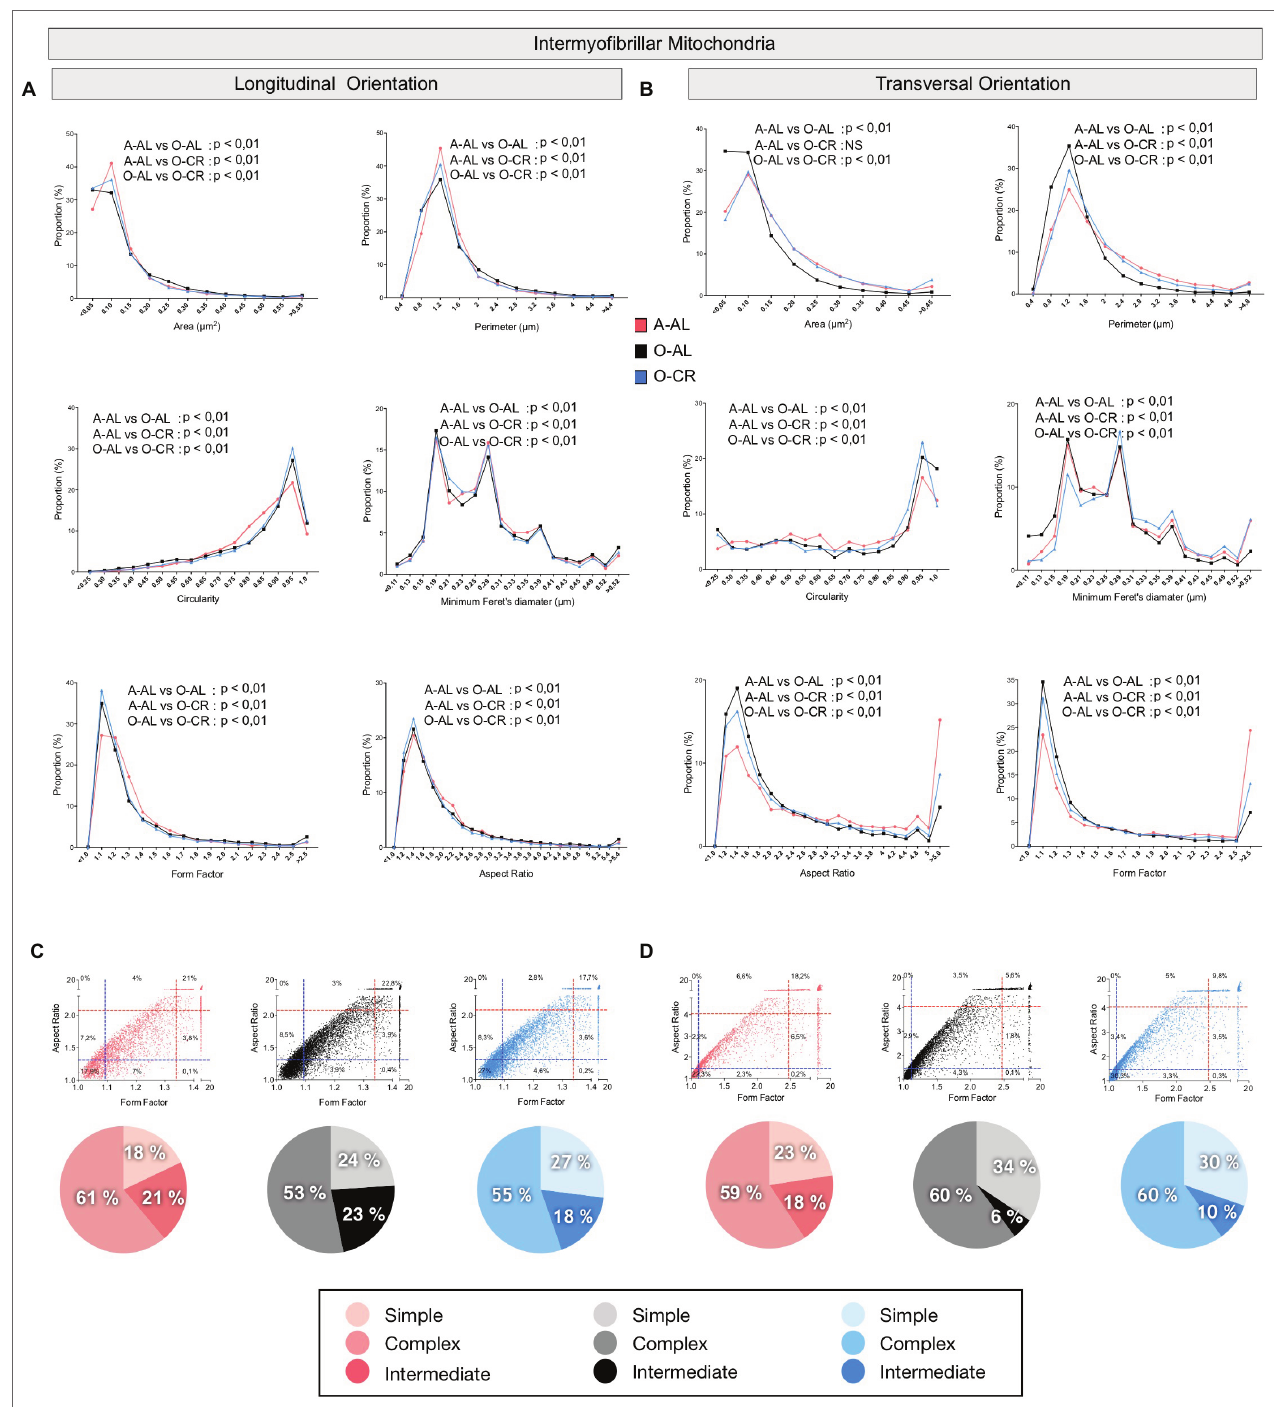
FIGURE 5 | Effect of aging and caloric restriction on the morphology of intermyofibrillar (IMF) mitochondria in the oxidative SOL muscle. Analyses of morphological parameters of mitochondria IMF in the SOL muscle (longitudinal and transversal orientation). (A) and (B) Frequency distribution of shape descriptors and morphological for IMF mitochondria in longitudinal (A) and transversal orientations (B) . (C) and (D) display the form factor and aspect ratio relationship for individual IMF mitochondria for A-AL (left graph), O-AL (middle graph), and O-CR (right graph) rats in longitudinal (C) and transversal orientations (D) . In (C) and (D), blue and red dashed lines represent the 25th and 75th percentiles for either aspect ratio or form factor values of A-AL, respectively. The pie charts in the second line represent the percentage of mitochondria with simple (i.e. mitochondria with aspect ratio and form factors values inferior to the 25th percentile of A-AL values), complex (i.e. mitochondria with aspect ratio and form factors values above the 75th percentile of A-AL values) and intermediate (i.e. neither simple nor complex). Differences in frequency distributions were tested using a Kolmogorov–Smirnov test comparing cumulative